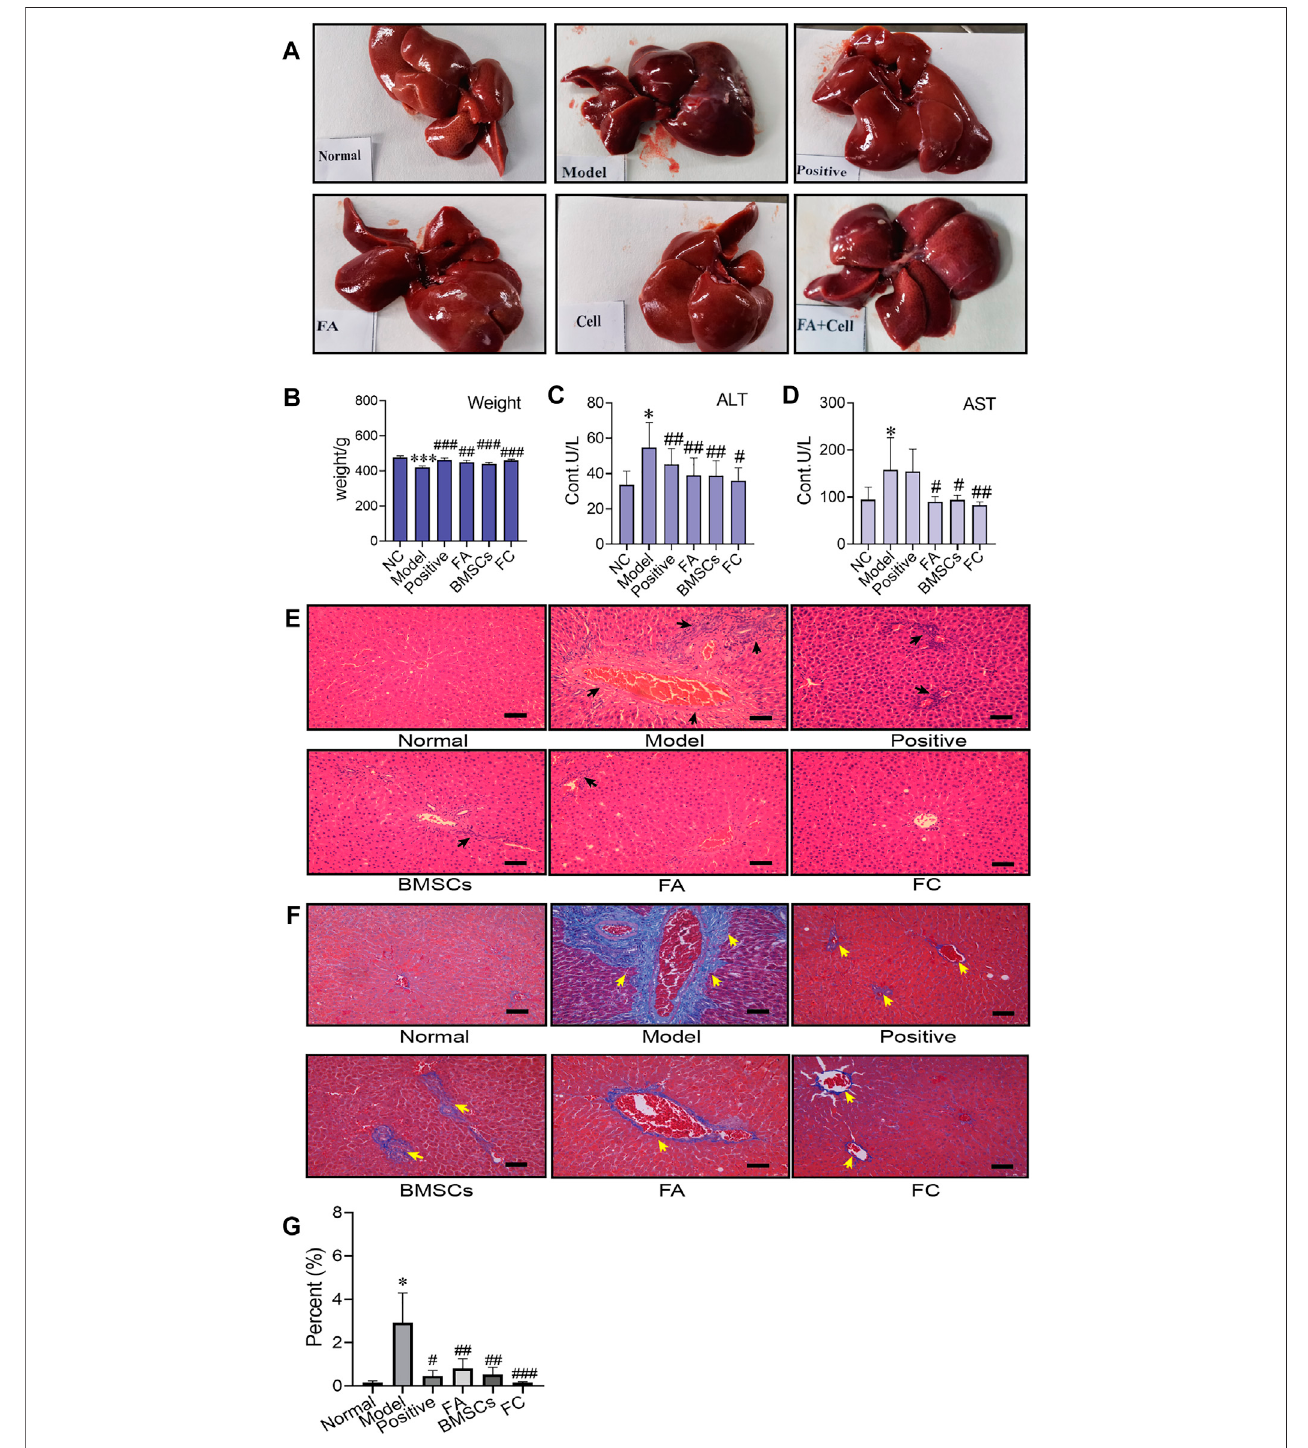
FIGURE 1 | Administration of BMSCs combined with FA ameliorates CCl 4 -induced liver injury in rats. (A) The liver appearance of each group (normal, model, positive,BMSC,FA,and FCgroups). (B) Comparison ofbodyweight amongthegroups (Two-way ANOVA; * p < 0.05, ** p < 0.01, *** p < 0.001versusthenormalgroup; # p < 0.05, ## p < 0.01, ### p < 0.001 versus the model group). (C , D) Serum levels of AST and ALT in each group ( n = 6). Data are presented as the mean ± SEM (Two- way ANOVA; * p < 0.05 versus the normal group; # p < 0.05, ## p < 0.01 versus the model group). (E) Images of HE-stained liver sections from representative animals in the normal, model, positive, BMSC, FA, and FC groups (original magni fi cation, ×10; scale bars, 100 µm, n = 6). (F) Masson stained liver sections from representative animals in the normal, model, positive, BMSC, FA, and BMSC&FA groups (original magni fi cation, ×10; scale bars, 100 μ m). The yellow squares indicate collagen. (G) The percentage of collagen area of Masson staining in each group ( n = 6). Data are presented as the mean ± SEM (Two-way ANOVA; * p < 0.05 versus the normal group; # p < 0.05, ## p < 0.01, ### p < 0.001 versus the model group).